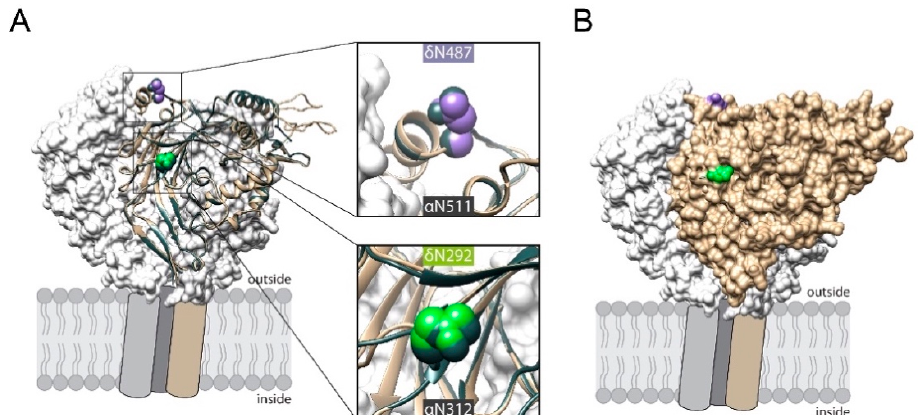
Figure 3. ( A ) Cartoon representation of human δ ENaC´s extracellular domain (highlighted in tan) that is aligned to human α ENaC, coloured in slate grey. Extracellular domains of wt β (grey) and γ subunit (white) are shown as surface representation. The predicted localization of the inserted asparagines 292 (green) and 487 (purple) are highlighted together with the corresponding asparagines in α ENaC (N312 and 511, slate grey). ( B ) Solvent accessible surface representation of δ ENaC indicates that the inserted asparagine residues are localised at exposed positions.